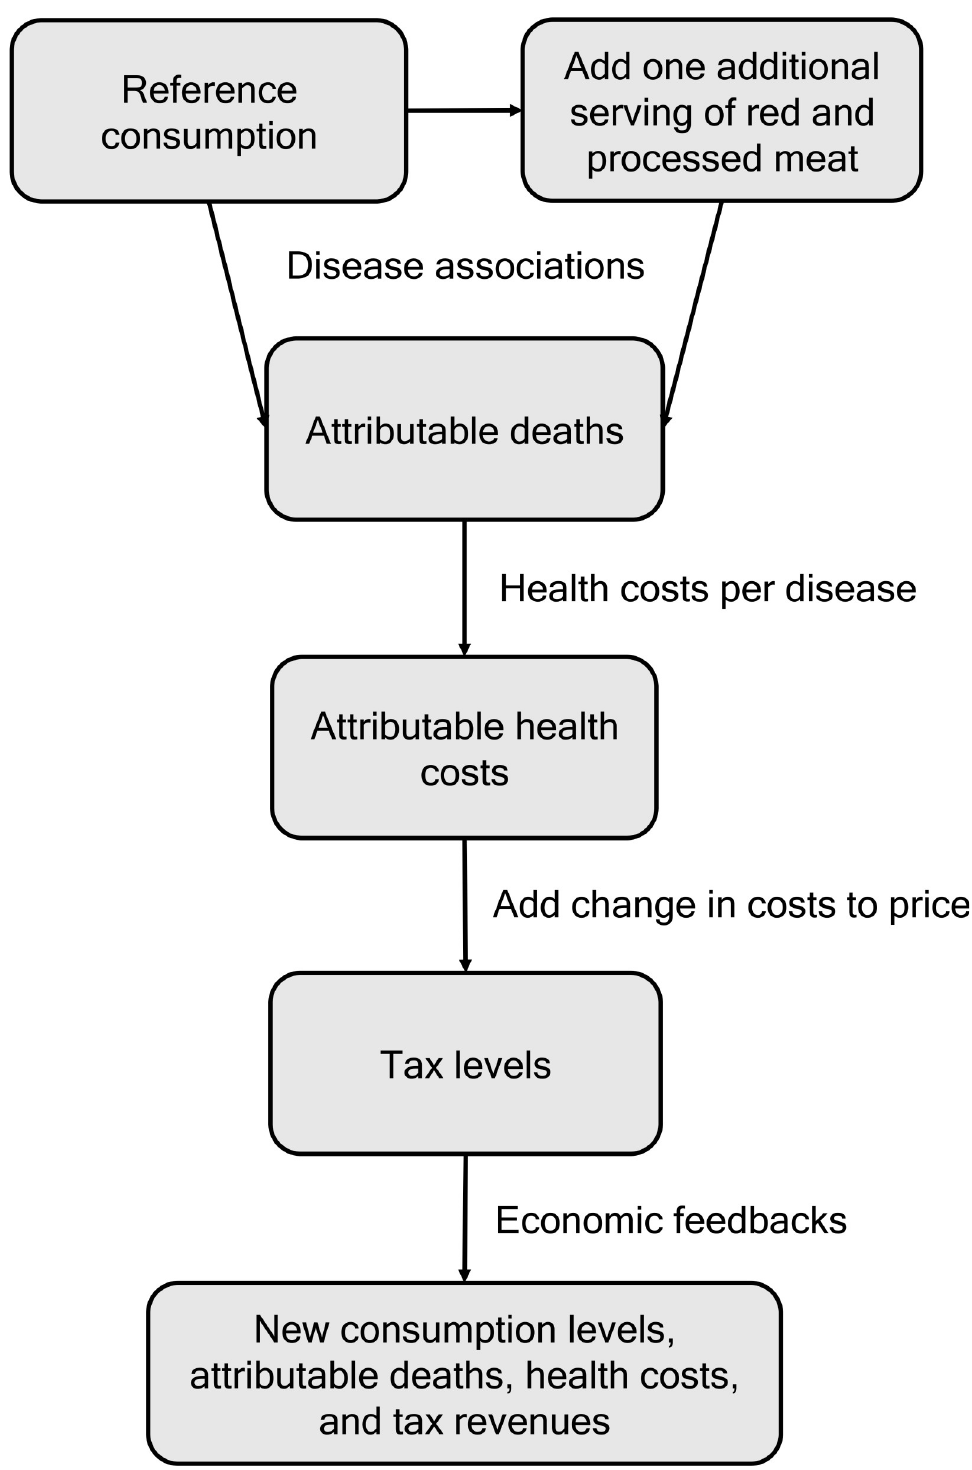
Fig 1. Schematic of algorithm used to calculate optimal tax levels for red and processed meat based on the marginal health costs associated with red and processed meat consumption.